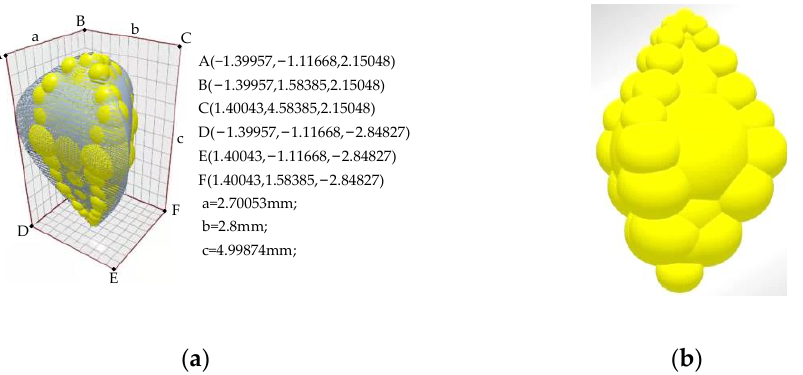
Figure 7. Particle model of buckwheat. ( a ) Schematic diagram of particle filling; ( b ) particle model.